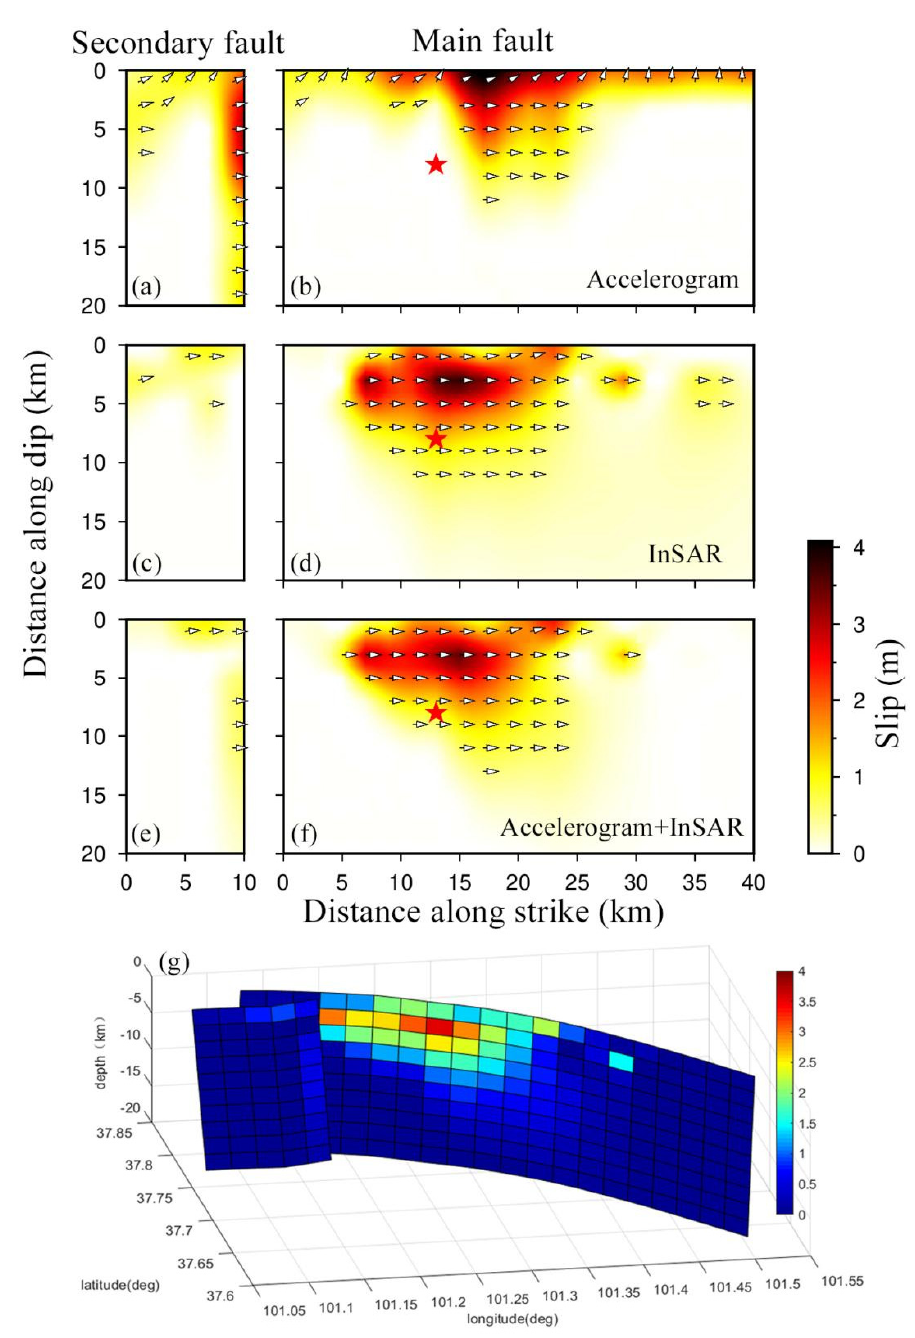
Figure 7. ( a , b ) Slip distributions from accerogram data only. ( c , d ) Slip distribution from InSAR data only. ( e , f ) Slip distribution from a joint inversion. ( g ) Three − dimension view of fault slip distribution from the joint inversion, shown in ( e , f ).